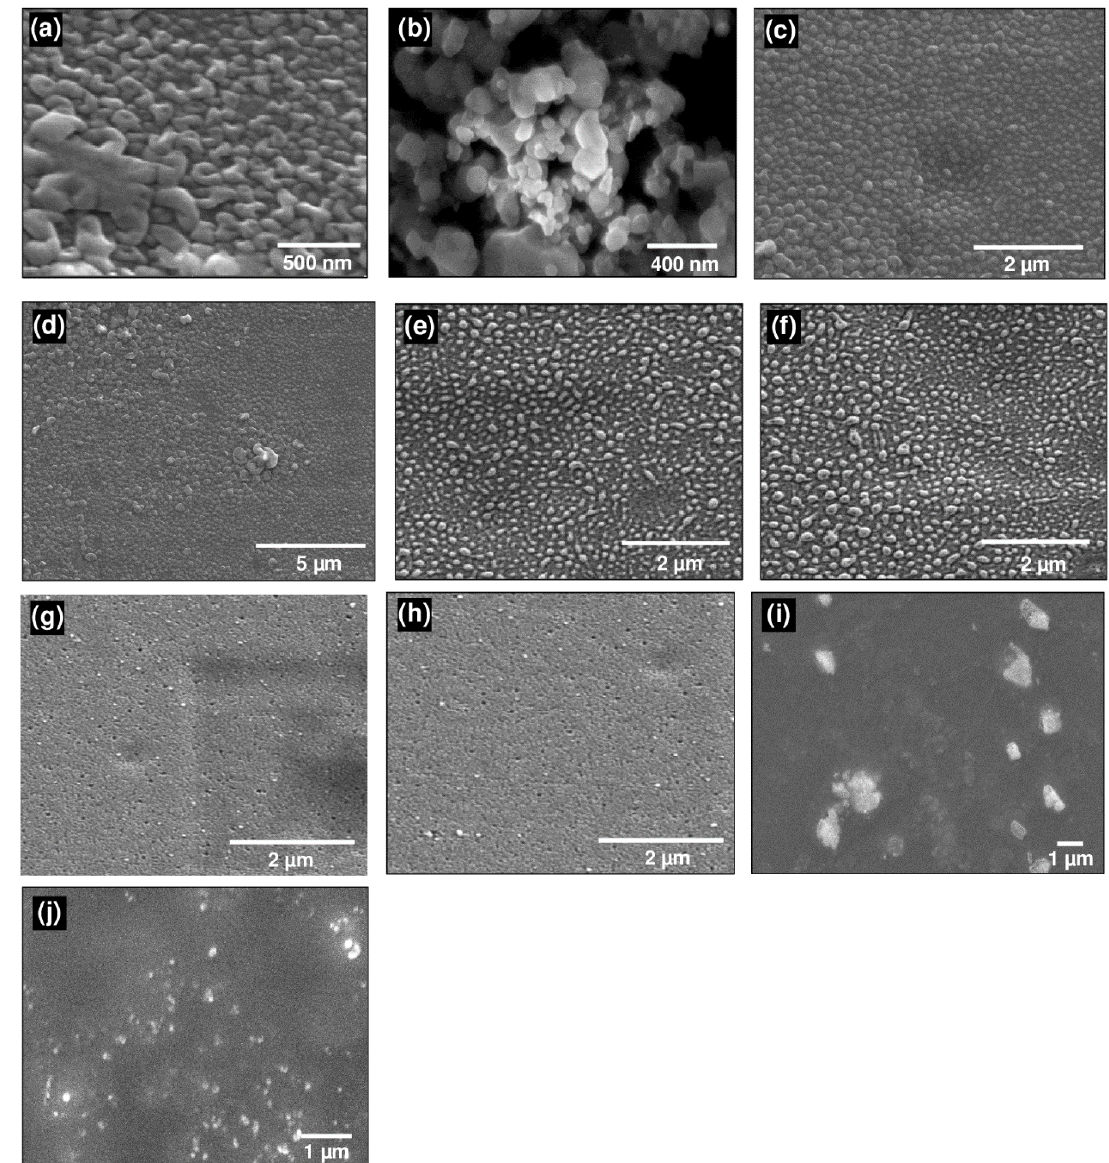
Figure 5. SEM micrographs of: ( a ) Ag–NPs (chemical synthesis); ( b ) Ag–NPs (green synthesis); ( c ) 3%